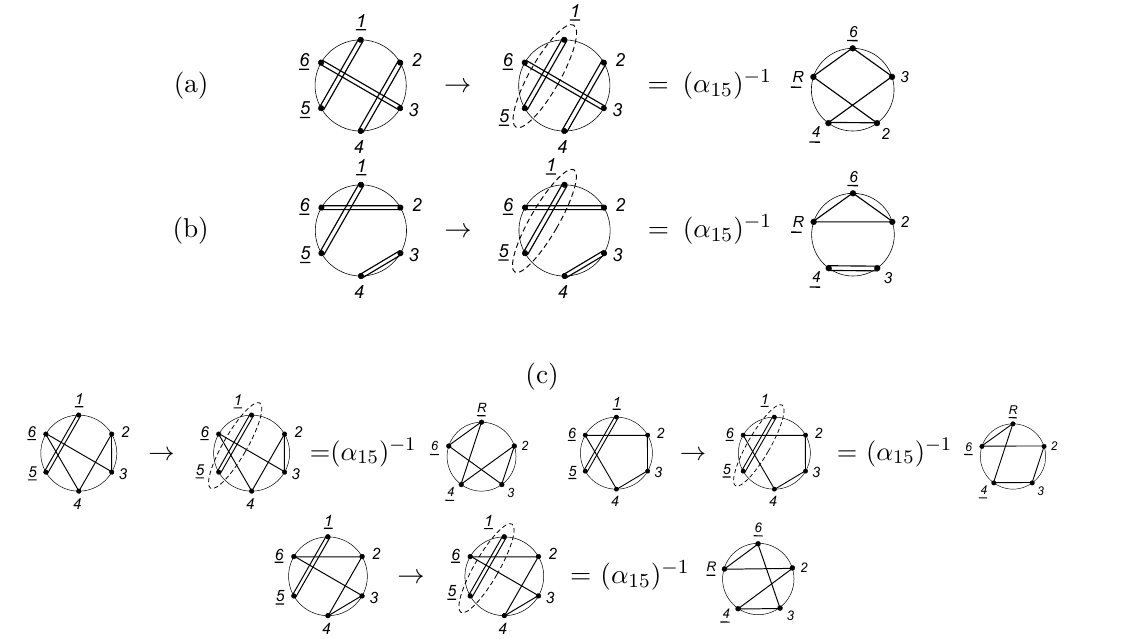
Figure 9 . (a) Computing the A ( b ) diagram. (b) Computing the A ( c ) diagram. (c) Computing the A ( d ) , A ( e ) , and A ( f )